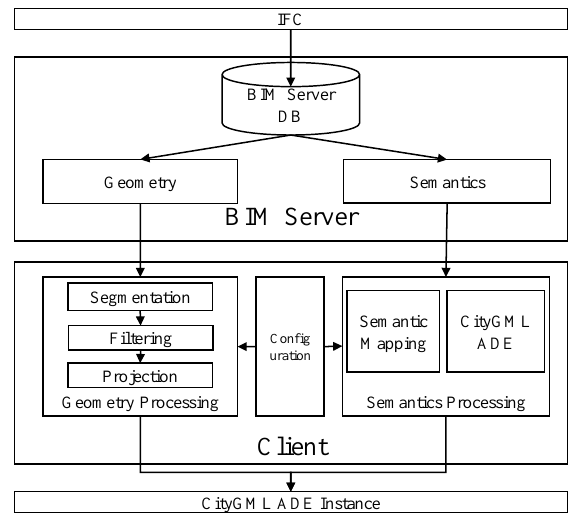
Figure 6. Implementation Architecture to generate an instance of CityGML ADE from IFC.